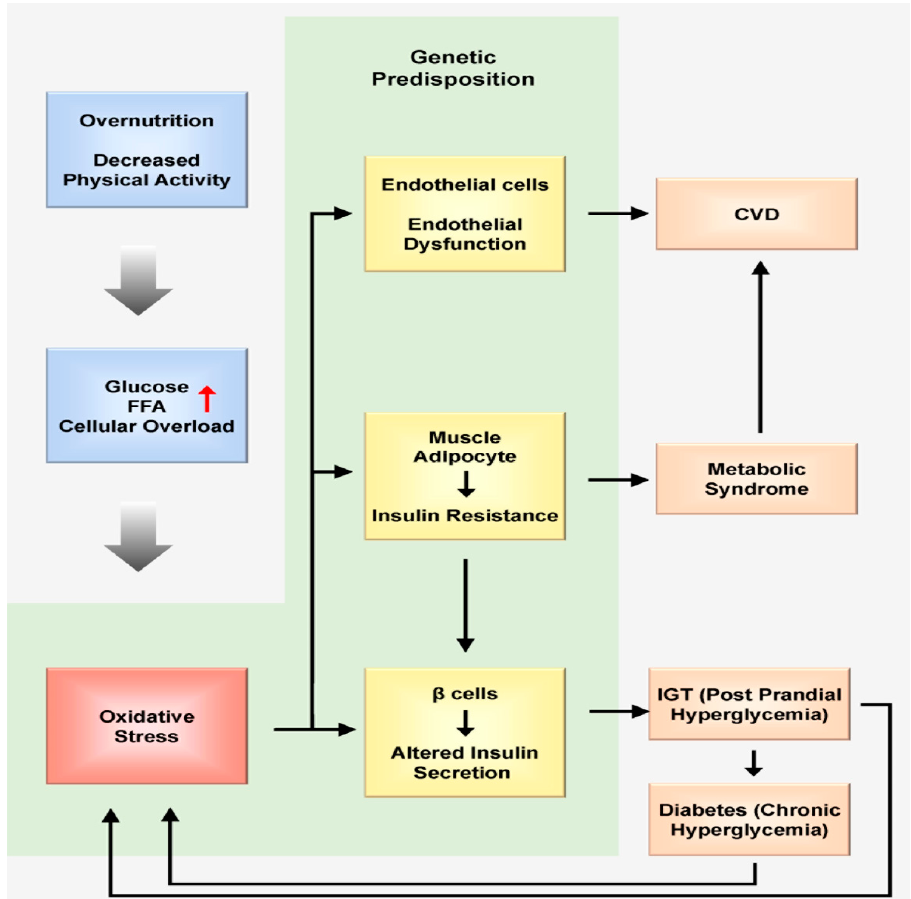
Figure 1. Overnutrition and decreased physical activity lead to overloaded glucose and free fatty acid (FFA) levels in cells. Their conversion into energy is supplemented by augmented free radical generation (oxidative stress). The muscle adipocytes can defend themselves from this situation and exhibit insulin resistance, aiming to decrease glucose and FFA permeation into the cells. The endothelial and β cells are insulin-independent. In these cells, glucose and FFA overload may cause oxidative stress, which in turn induces dysfunction of both endothelial and β cells. Endothelial dysfunction may induce cardiovascular disease (CVD), and β cell dysfunction is characterized by altered insulin secretion. β cell dysfunction is particularly characterized by a decrease in first-phase insulin secretion, which in turn produces the clinical situation of impaired glucose tolerance (IGT). This last condition is clinically characterized by increased postprandial hyperglycemia. Postprandial hyperglycemia induces oxidative stress. The persistence of this condition exhausts β cells, leading to overt diabetes. Oxidative stress produced during both IGT and overt diabetes may contribute to the development of CVD. Moreover, the cluster of risk factors that accompany insulin resistance also contributes to CVD development. Red colored arrow represents overload (Adapted from [49]).